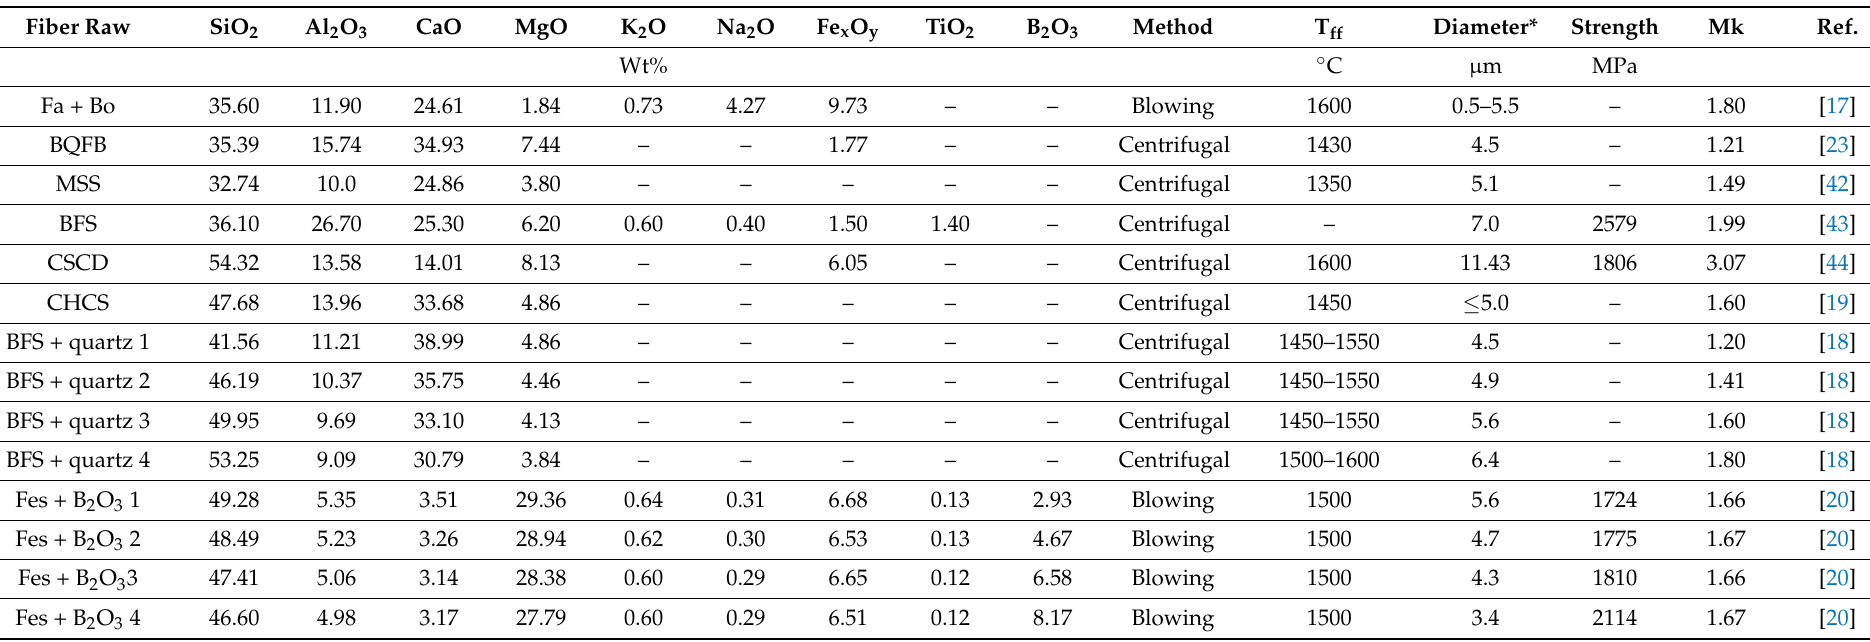
Table 1. Chemical composition, production method, mean diameter, tensile strength of the mineral fibers from solid wastes in recent 12 years. Fiber Raw